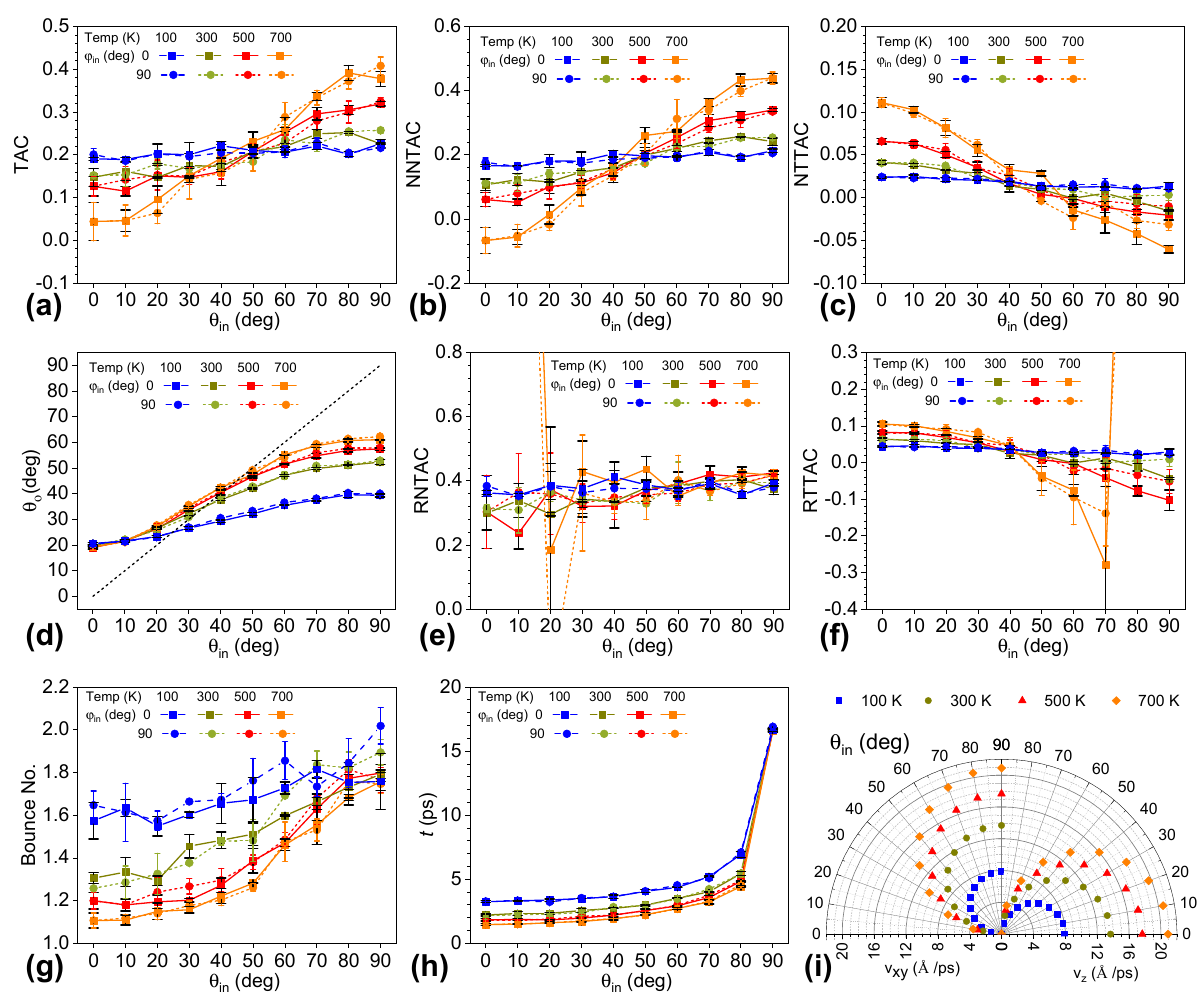
Figure 5. ( a ) TAC, ( b ) NNTAC, ( c ) NTTAC, ( d ) zenith angle of the scattered helium, ( e ) RNTAC, ( f ) RTTAC, ( g ) bounce number of helium, and ( h ) total collision time versus zenith angle of the incident helium with the azimuthal angle at 0° and 90°, respectively, and the speed of helium is set at the temperatures of 100 K, 300 K, 500 K, and 700 K. The graphene temperature was 1000 K. In ( e , f ), the curves for 700 K were out of scope at one end. ( i ) Polar plot of in-plane (v xy , left panel) and normal (v z , right panel) components of incident helium with the zenith angle of the incident helium. The nonlinearity between θ o and θ in remained for all cases with helium temperatures from 100 K to 700 K, as shown in Figure 5d. For systems with lower helium temperatures, the enhancement in θ o with a larger θ in would be suppressed as θ in was greater than 20 ◦ , and the slope of the linear segment of the θ o against θ in curve decreased. In this way, the specular reflectance angle of the incident helium was in the range of 20 ◦ ~30 ◦ , 30 ◦ ~40 ◦ , 40 ◦ ~50 ◦ ,